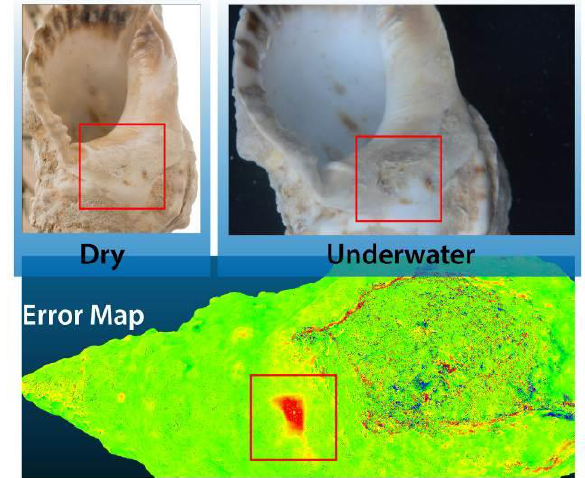
Figure 10. Detachment of a piece of shell, caused by a little incident during transfer